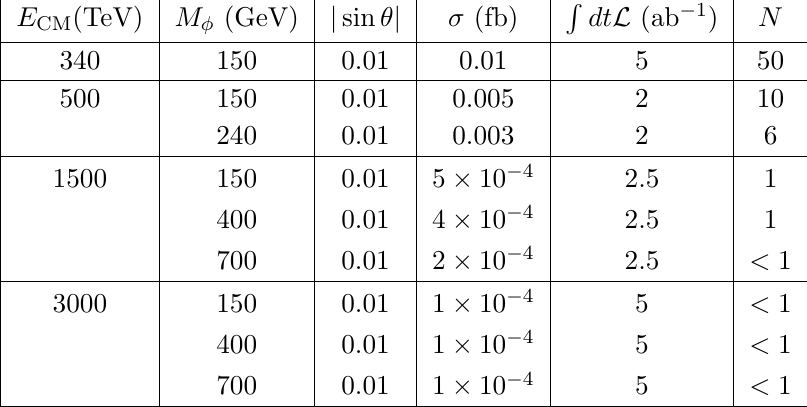
Table 3 . Single heavy Higgs production via associated production at prospective e + e (cid:0) colliders. over the parameters of the potential in eqs. (2.7a), (2.7b), (4.4), and requiring that the (cid:12)rst order EWPT completes (e.g., a su(cid:14)ciently large tunneling rate) and that the baryon number preservation criterion be satis(cid:12)ed. Hence, the benchmarks given in table 4 appear to be quite conservative.